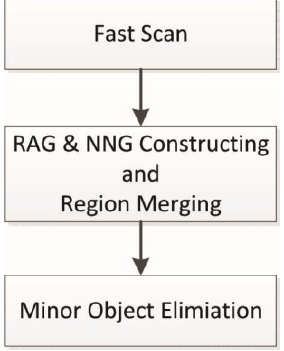
Figure 2. General steps of the proposed